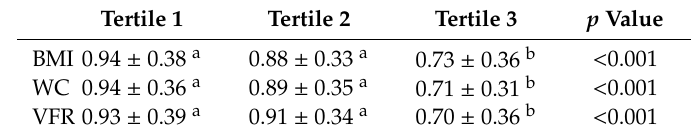
Table 2. 17-Hydroxyprogesterone levels (ng / mL) by tertiles of di ff erent measures of